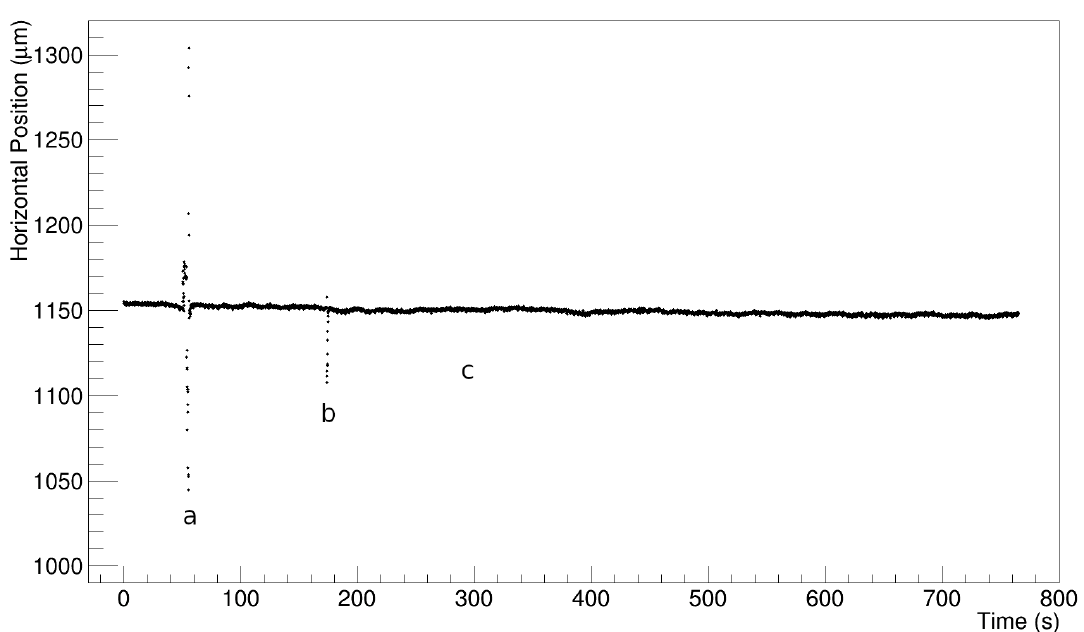
Figure 15. NanoMAX’s horizontal beam position. At t = 50 s ( point “a”), the MO RF is increased directly by 5 Hz. The horizontal X-ray beam position oscillates as much as ∼ 150 µ m as a result of MO RF increase. At t = 174 s (point “b”), the MO RF is decreased by 10 Hz directly, and, once more, a large disturbance in the delivered beam for NanoMAX is observed. At 285 s ( point “c”), the MO RF starts to be increased towards a total 5 Hz change using the sweeper, which takes approximately 5 min, but the change is not noticeable in the